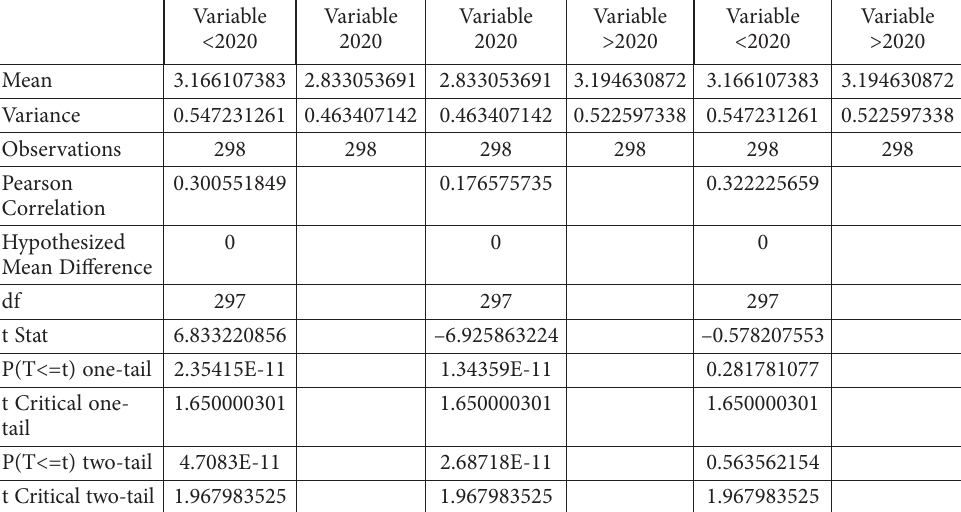
Table 2. Results of the t-test for the period before (<2020), during (2020), and after the lockdown (>2020) (source: prepared by authors) t-Test: Paired Two Sample for